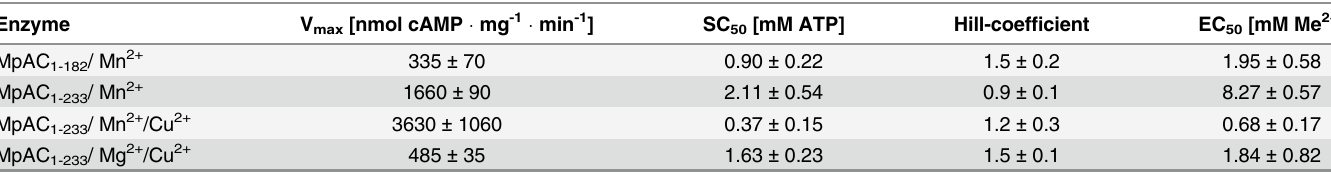
Stimulation of full-length M . phlei adenylyl cyclase by copper ions with Mn 2+ as a cofactor The hypothesis of the YHS-domain of M . phlei AC being a transition-metal ion binding domain with similarity to the YHS-domains of CuATPases was tested in assays of the untagged Table 1. Kinetic parameters of MpAC 1-182 and MpAC 1-233